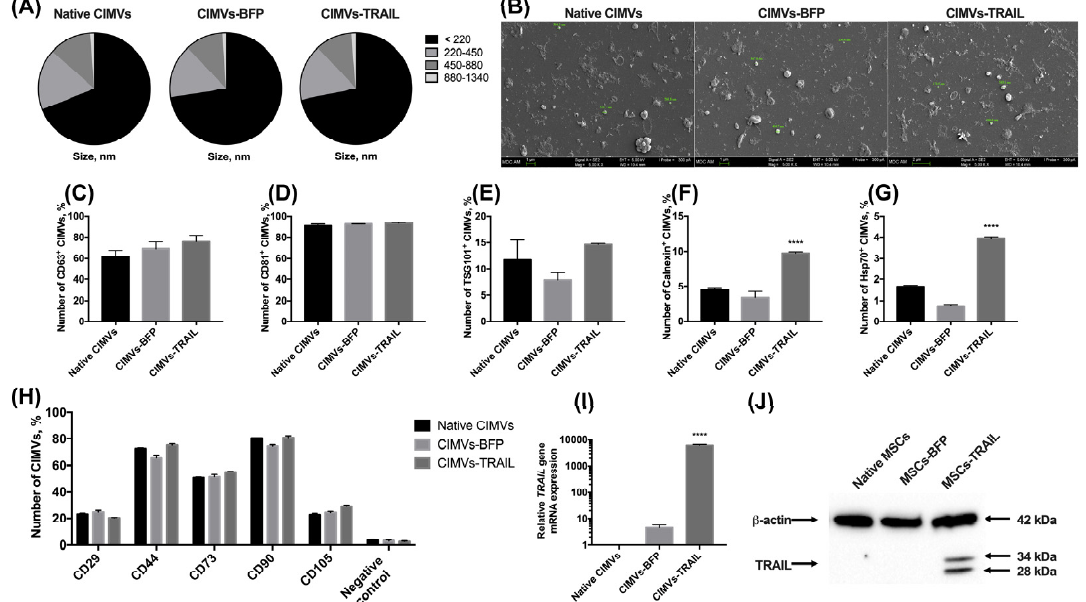
Figure 3. The size of cytochalasin B-induced membrane vesicles (CIMVs) was analyzed using flow cytometry ( A ) and SEM ( B ), where the majority of the CIMVs were less than 220 nm in diameter. The isolated vesicles expressed the major markers of extracellular vesicles CD63 ( C ) and CD81 ( D ). At the same time, the expression level of TSG101 ( E ) and intracellular proteins calnexin ( F ) and Hsp70 ( G ) was low. ( H ) The expression of typical surface MSC markers was significantly reduced in both native and genetically modified CIMVs compared to the parental cells. The presence of the TRAIL gene mRNA ( I ) and TRAIL protein ( J ) in the isolated CIMVs was confirmed using qPCR and Western blot, accordingly. Each box represents the mean ± SD ( n = 3) of three replicates. **** p < 0.0001.